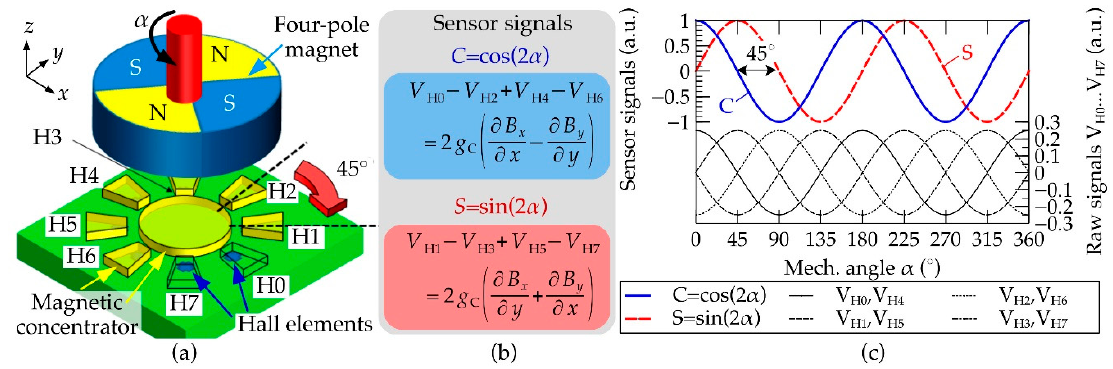
Figure 1. Concept of the rotary position sensor system. ( a ) The four-pole magnet provides in-plane flux density gradients to the sensing device consisting of eight circularly arranged Hall elements and a magnetic concentrator. ( b ) The in-plane flux density gradients in combination with the concentrator gain g C give rise to eight raw signals V H0 ... V H7 out of which the sensor signals C = V H0 − V H2 + V H4 – V H6 and S = V H1 – V H3 + V H5 – V H7 are composed, representing cos(2 α ) and sin(2 α ), respectively. ( c ) Calculated values of the raw signals and the sensor